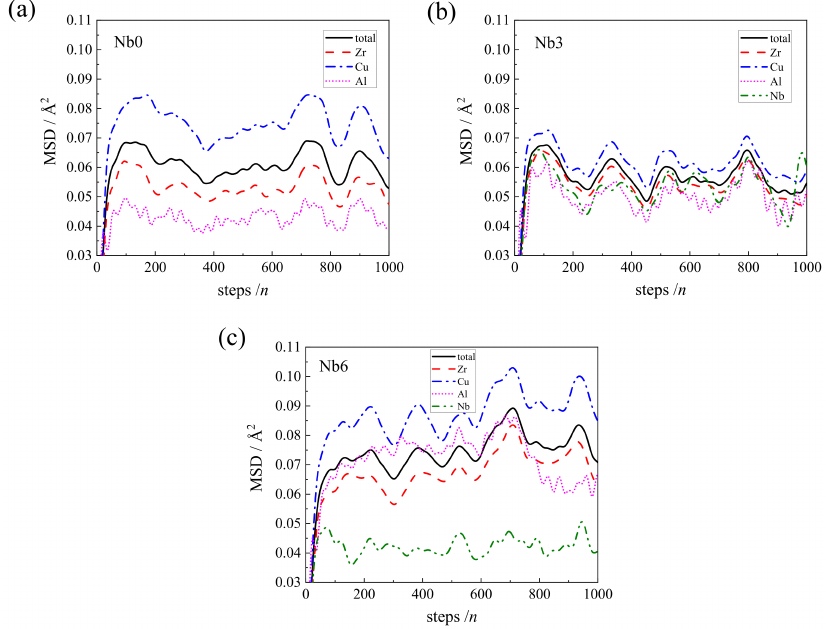
Figure 5. MSD curves of various elements of the alloy simulated by AIMD at 300 K: ( a ) Nb0; ( b ) Nb3 and ( c )